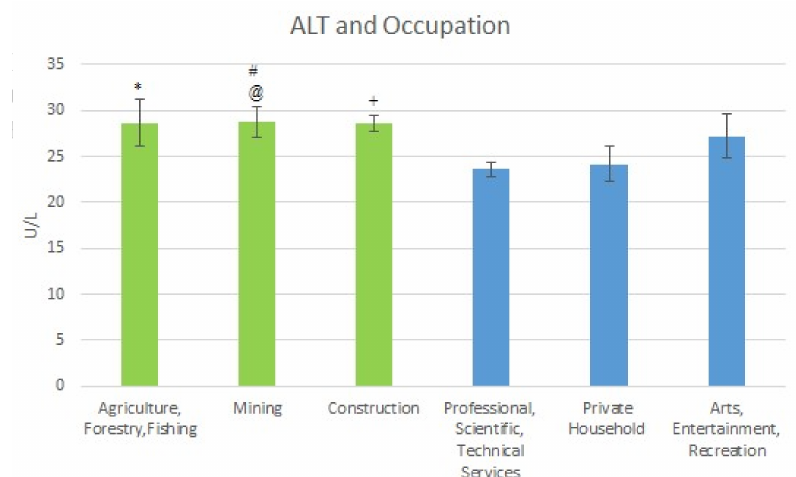
Figure 3. Occupation and Mean ALT Levels. * Moderately significant difference between Agriculture and Professional Scientific, Technical Services. # Significant difference between Mining and Professional Scientific, Technical Services. @ Moderately significant difference between Mining and Private Households. + Significant difference between Construction and Professional Scientific, Technical Services, and Private Households.